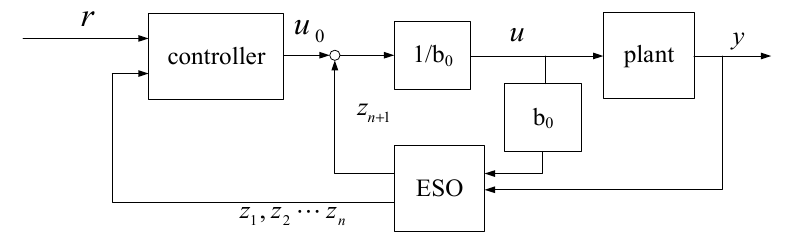
Figure 1. Block diagram of